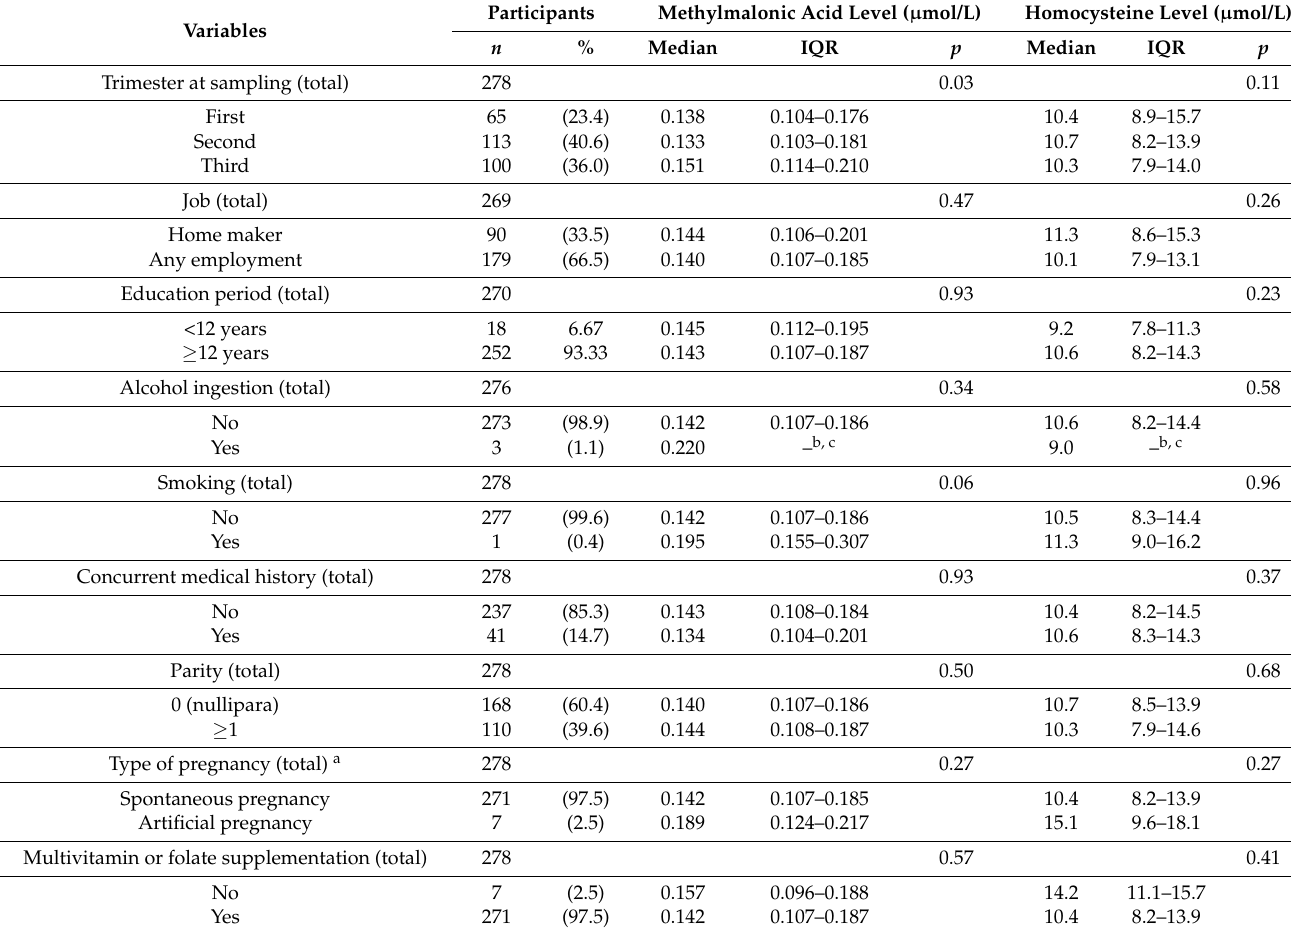
Table 2. Association between demographic characteristics and serum methylmalonic acid and homocysteine levels and their status in pregnant Korean